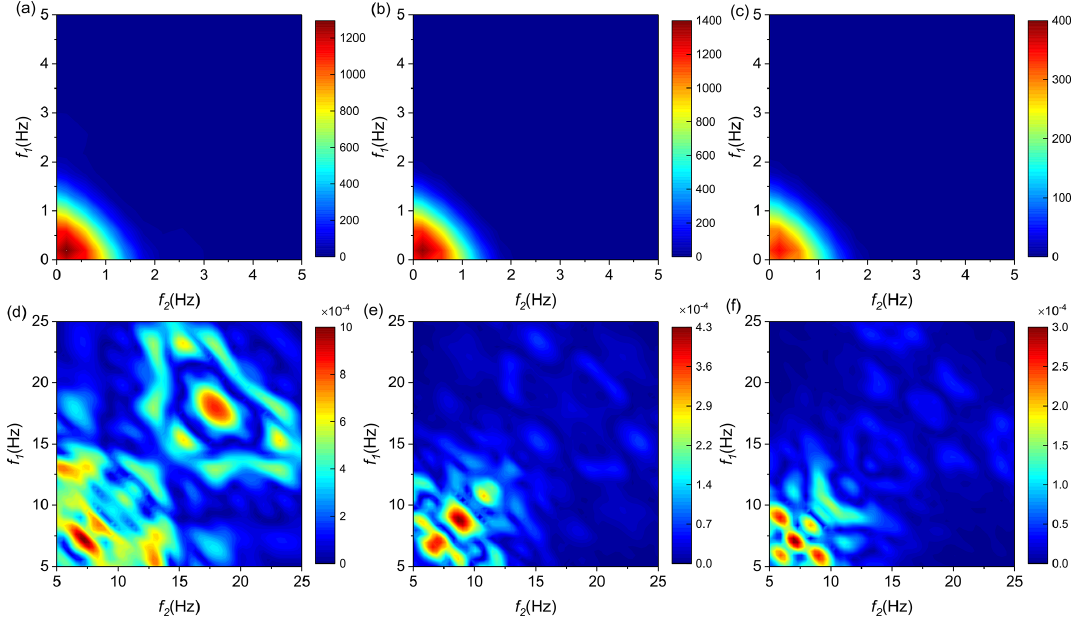
Figure 6. Color contour maps of bispectra of the streamwise velocity fluctuations B ( f 1 ,f 2 ) at (a) the rising stage, (b) the steady stage, and (c) the declining stage of the sandstorm. Bispectra of the high-frequency band of streamwise velocity fluctuations at (d) the rising stage, (e) the steady stage, and (f) the declining